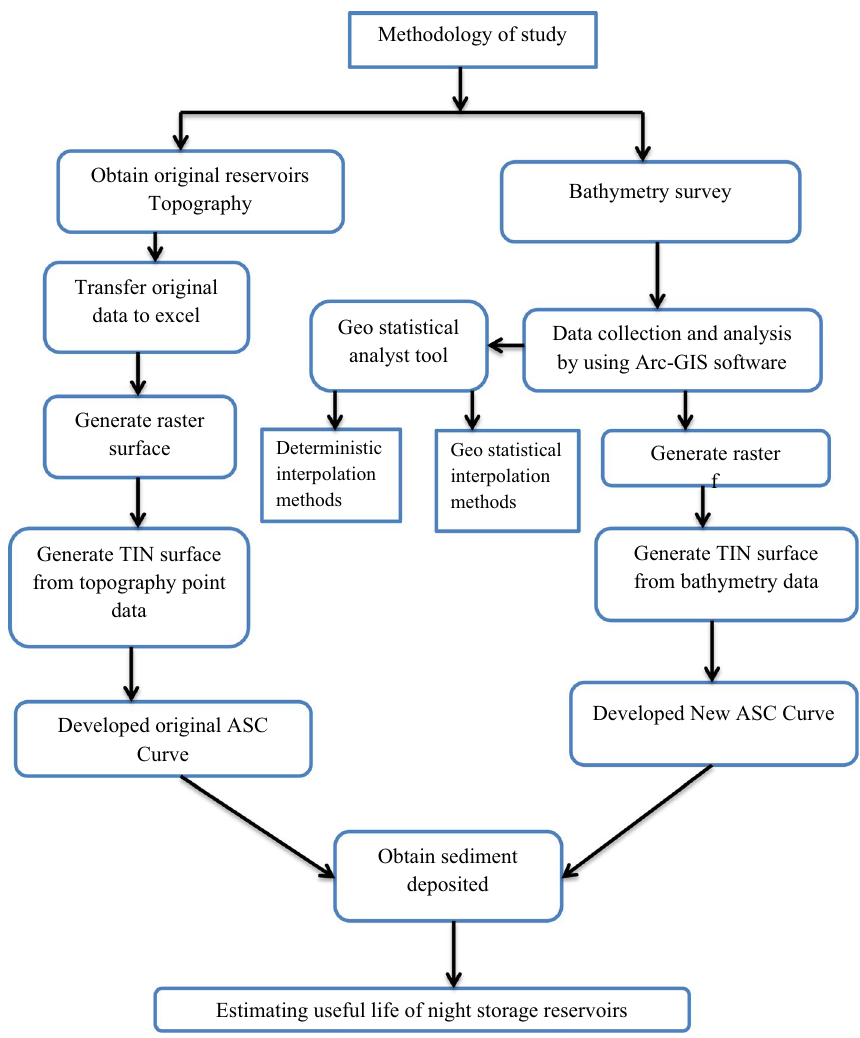
Fig. 4 Flowcharts of